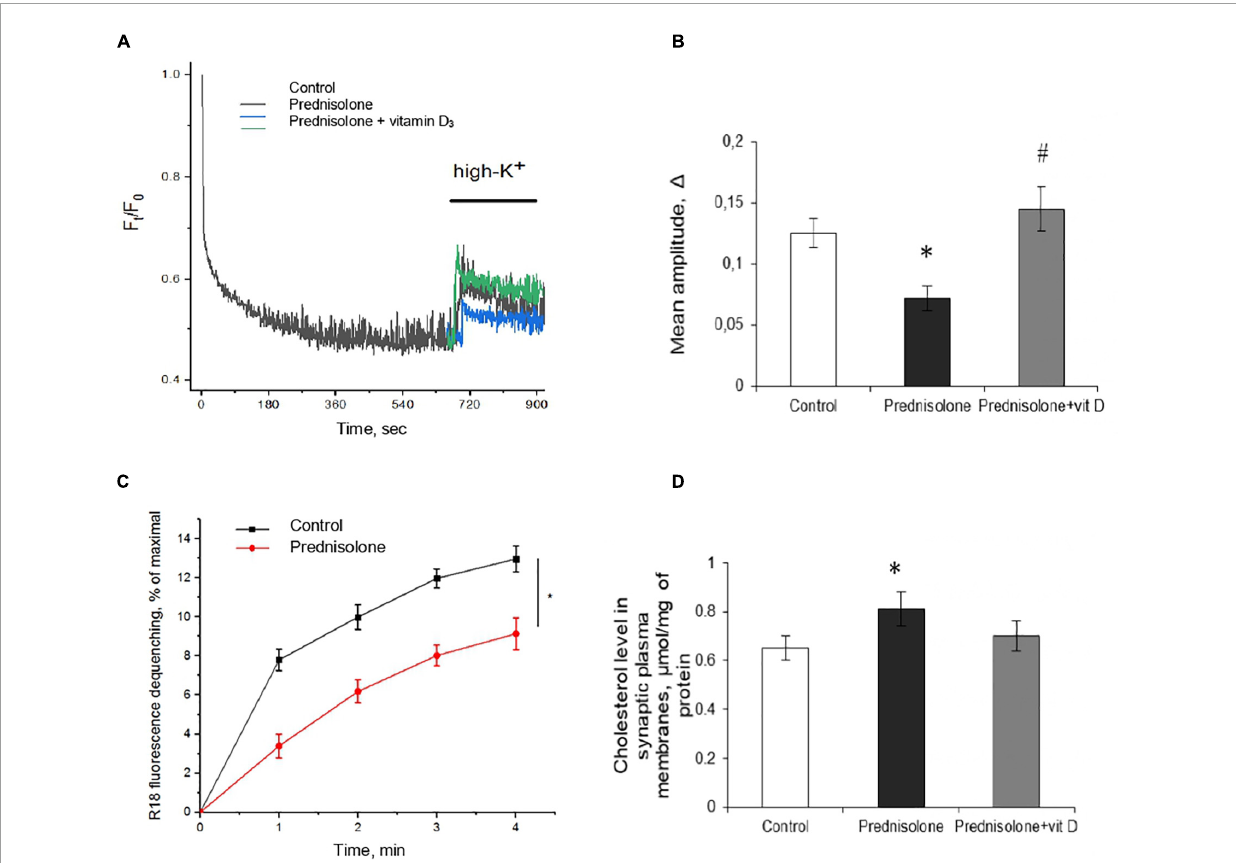
FIGURE6 Glucocorticoid-induced disturbances of synaptic function and its correction by the vitamin D 3 supplementation. Depolarization-induced exocytosis in rat brain nerve terminals (synaptosomes) (A) and quantification of the mean amplitude (cid:49) (B) . Nerve terminals were isolated from the control, prednisolone-treated and prednisolone plus vitamin D 3 -treated rats. Spectrofluorimetric registration of pH-sensitive dye – acridine orange (AO), n = 4. The rate of synaptic vesicle fusion with plasma membranes in cell-free system (C) . Fusion was determined by monitoring of R18 fluorescence dequenching in suspension of R18-labeled synaptic vesicles and unlabeled synaptic plasma membranes upon Ca 2 + application in control and prednisolone-administered rats, n = 5 (traces). Cholesterol content in synaptic plasma membranes (D) of control and prednisolone-treated rats ( n = 5). All data are presented as mean ± SD of three independent experiments done in triplicate; ∗ p < 0.05 denotes significance compared with control, # p < 0.05 denotes significance compared with prednisolone